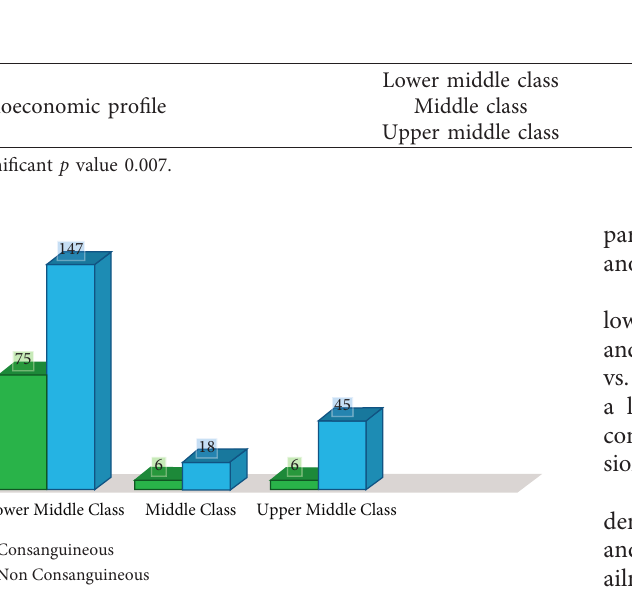
Figure 1: Association of consanguineous marriages and socio- economic